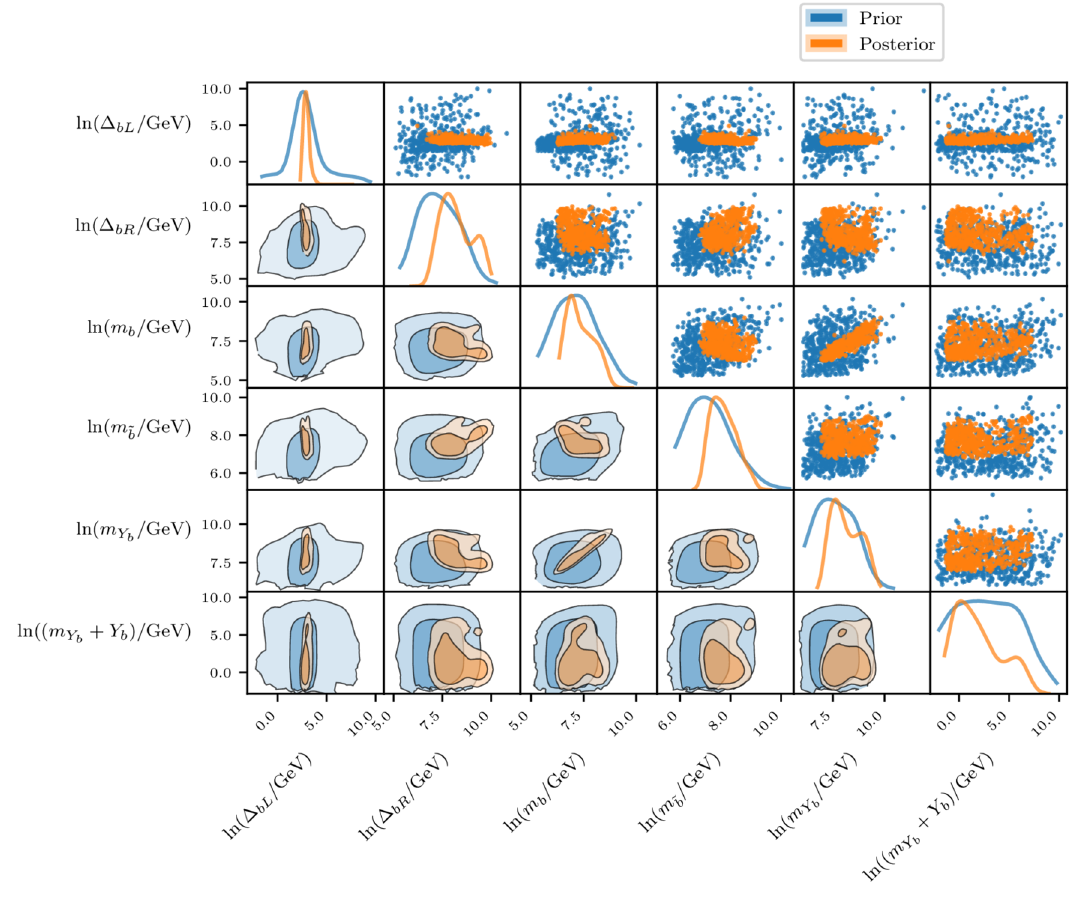
Figure 5. 1D and 2D marginalised priors and posteriors for the bottom partner parameters in the M4DCHM 5 − 5 − 5